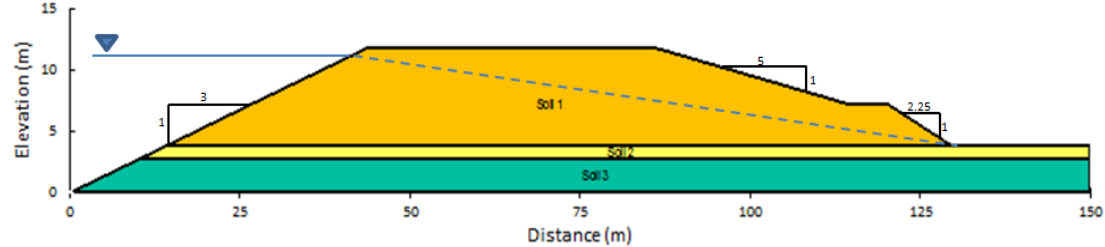
Figure 1. Cross-section of the earthen flood protection levee.